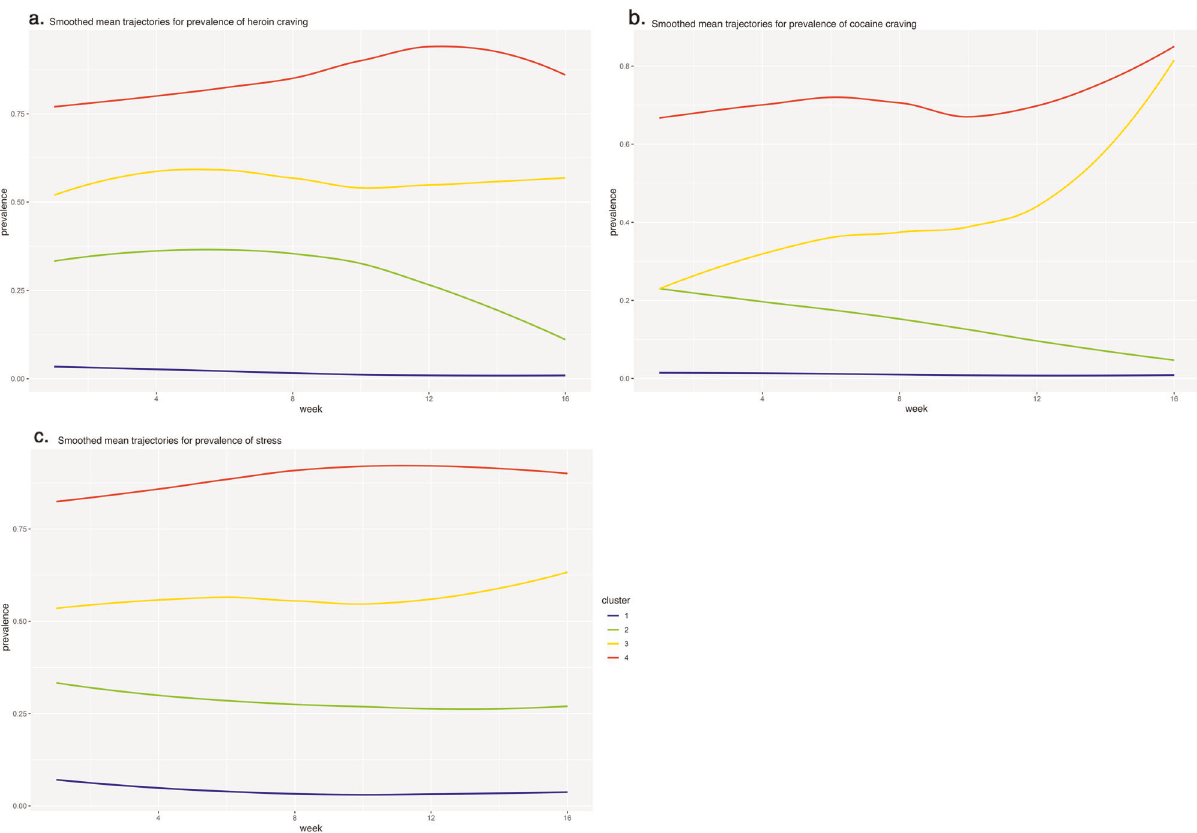
Fig. 6 Smoothed mean trajectories of heroin craving, cocaine craving, and stress in empirically derived clusters of participants. We labeled the clusters (1) low prevalence, (2) medium-decreasing prevalence, (3) medium-increasing prevalence, and (4) high